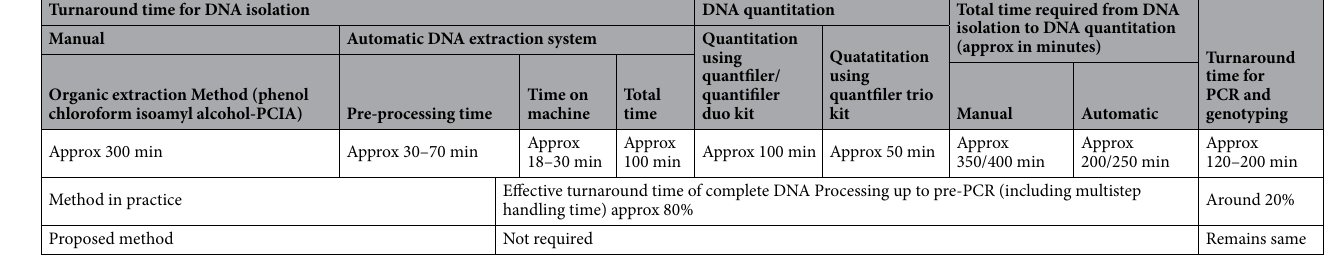
Table 2. Turnaround time for DNA typing